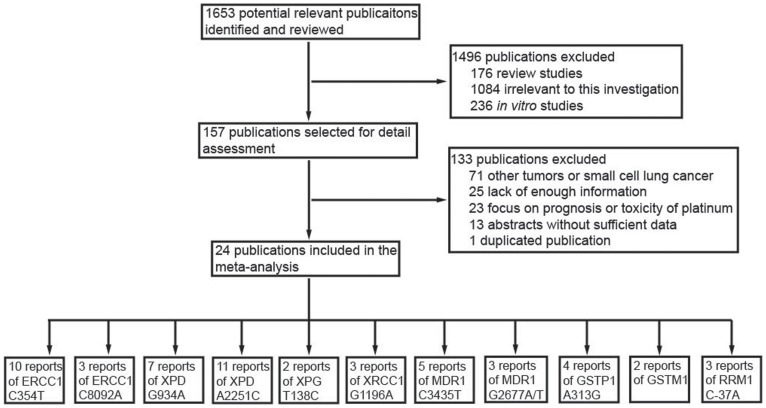
Flow chart of literature selection.